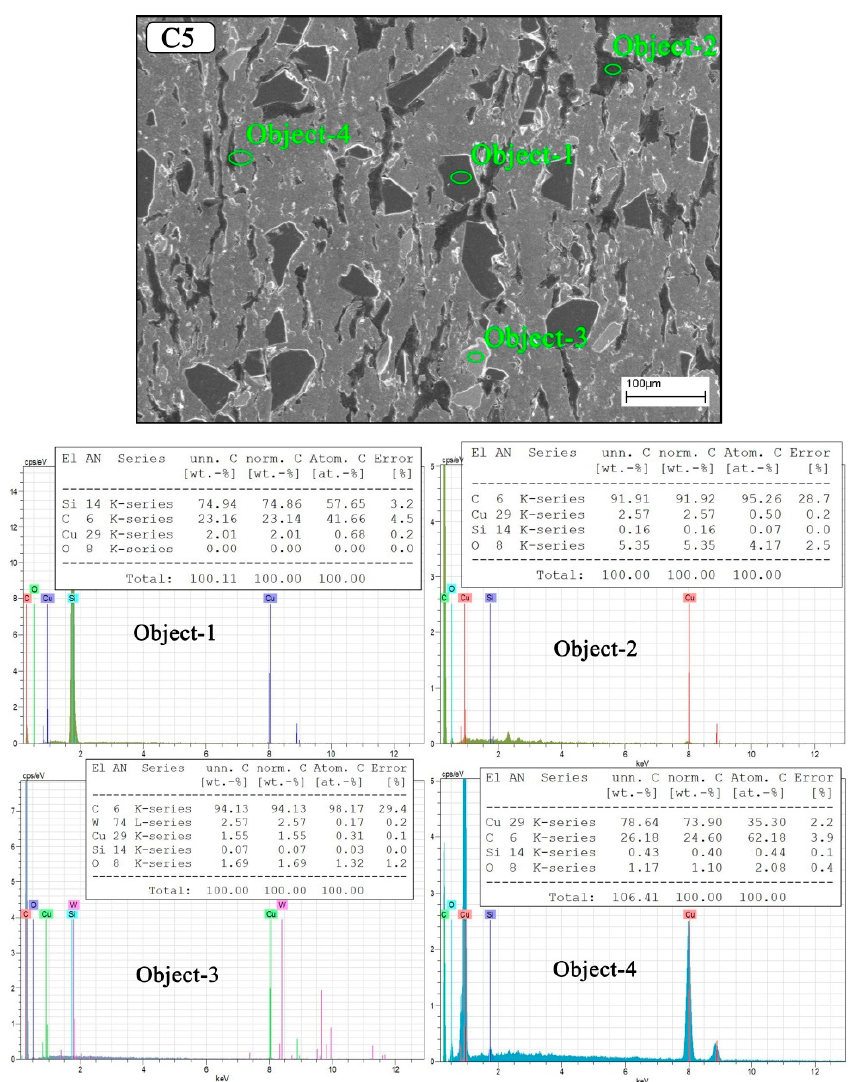
Figure 5. SEM/EDS images of copper composite sample C5.